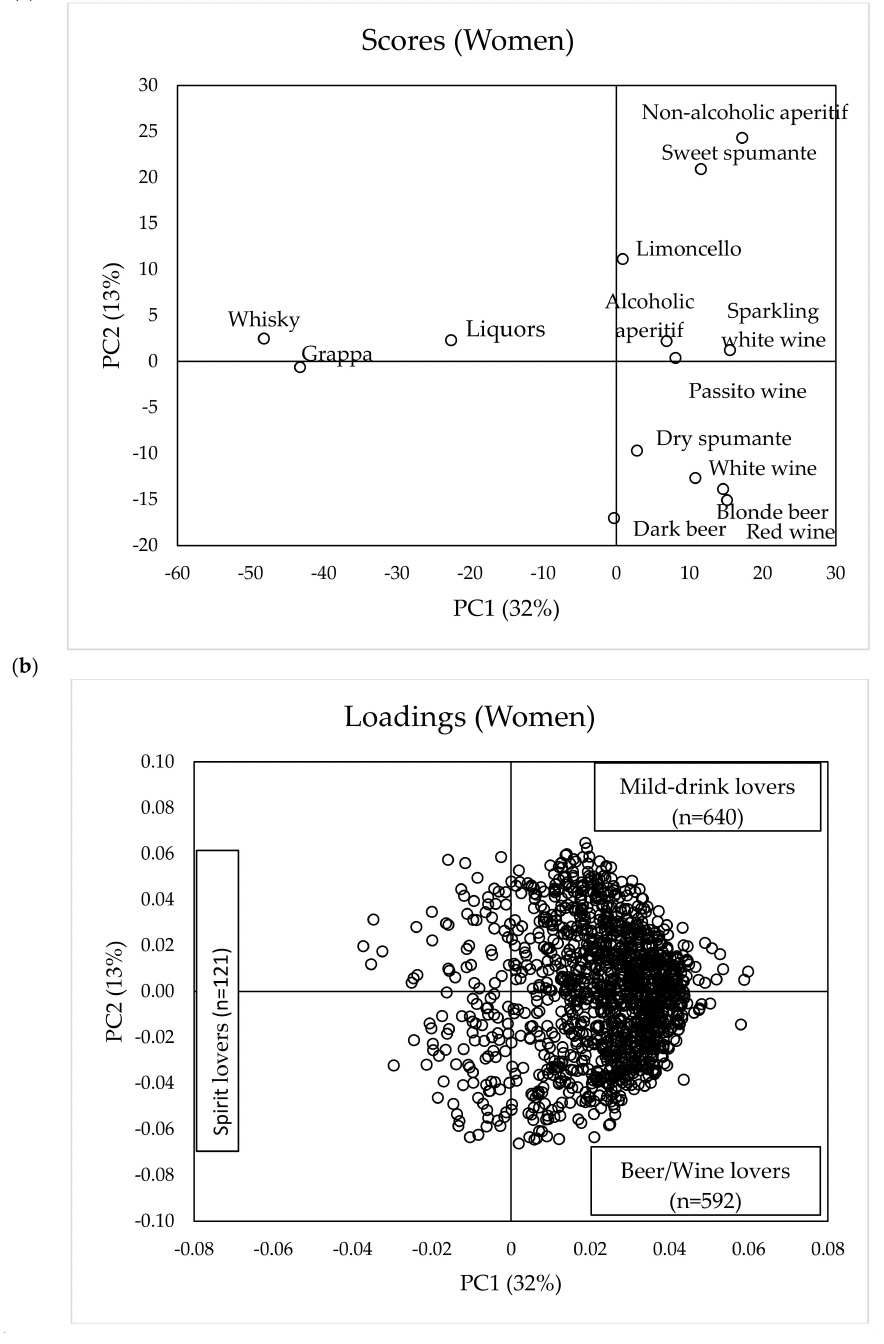
Figure 1. Scores ( a ) and loadings ( b ) obtained from principal component analysis (PCA) performed on liking (9-point hedonic scale) of di ff erent alcoholic beverages by women consumers ( n =